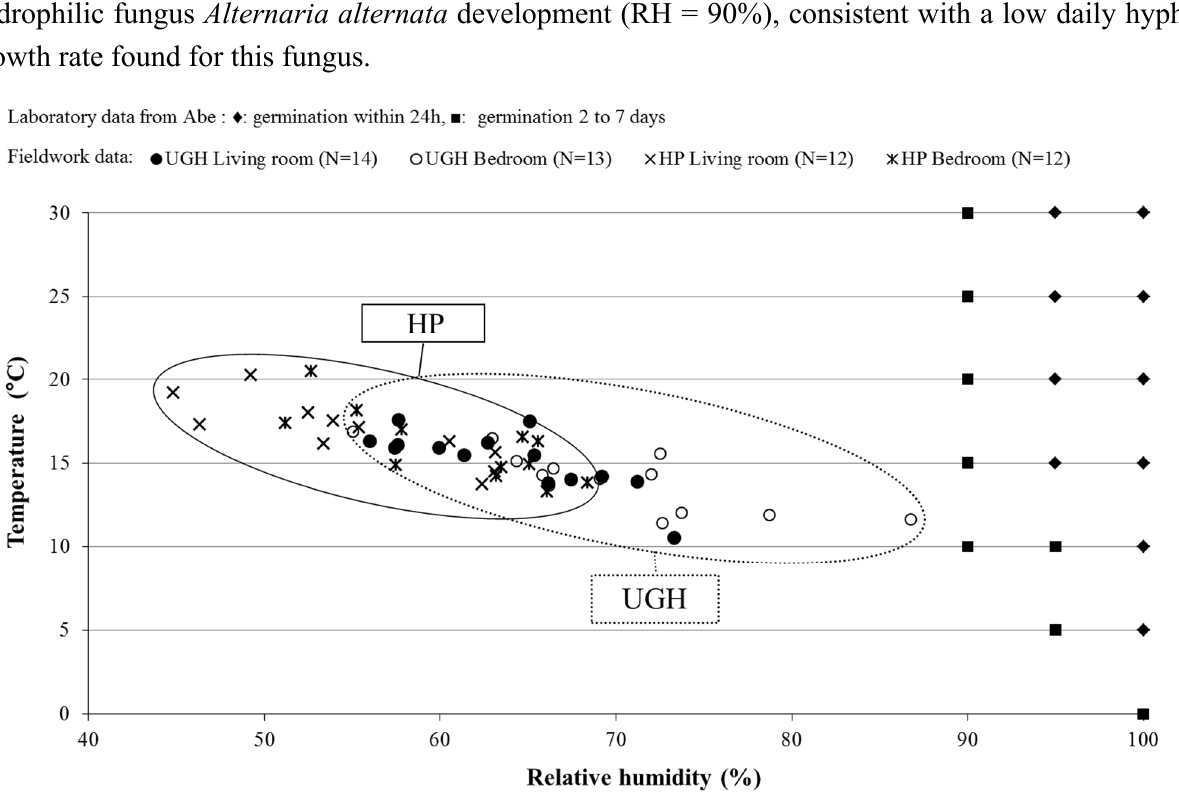
Figure 4. Climograph with germination of Alternaria alternate spores; fieldwork data compared to laboratory data (collected by Abe